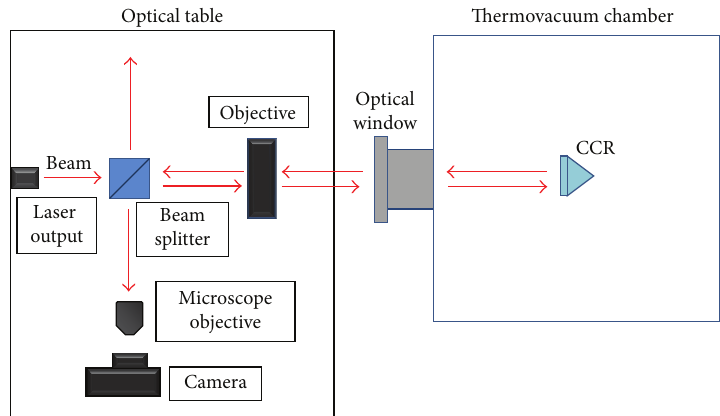
Figure 10: Schematic view of thermovacuum test